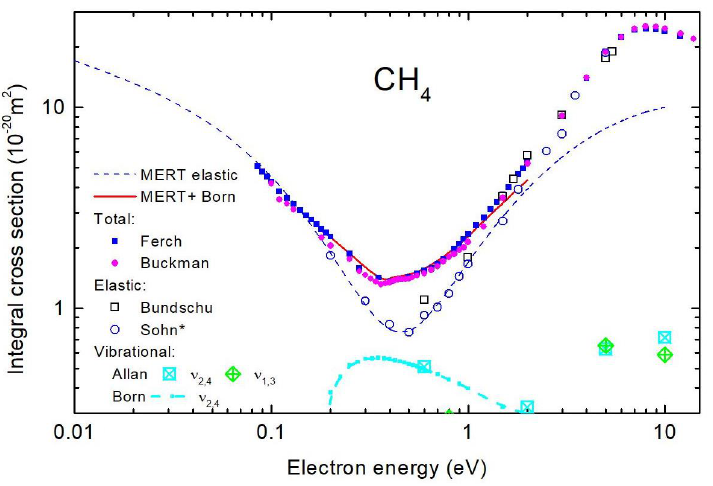
Figure 3. Integral (elastic, vibrational, total) cross sections for electron—CH 4 scattering in the low energy range. For references see reference [24].